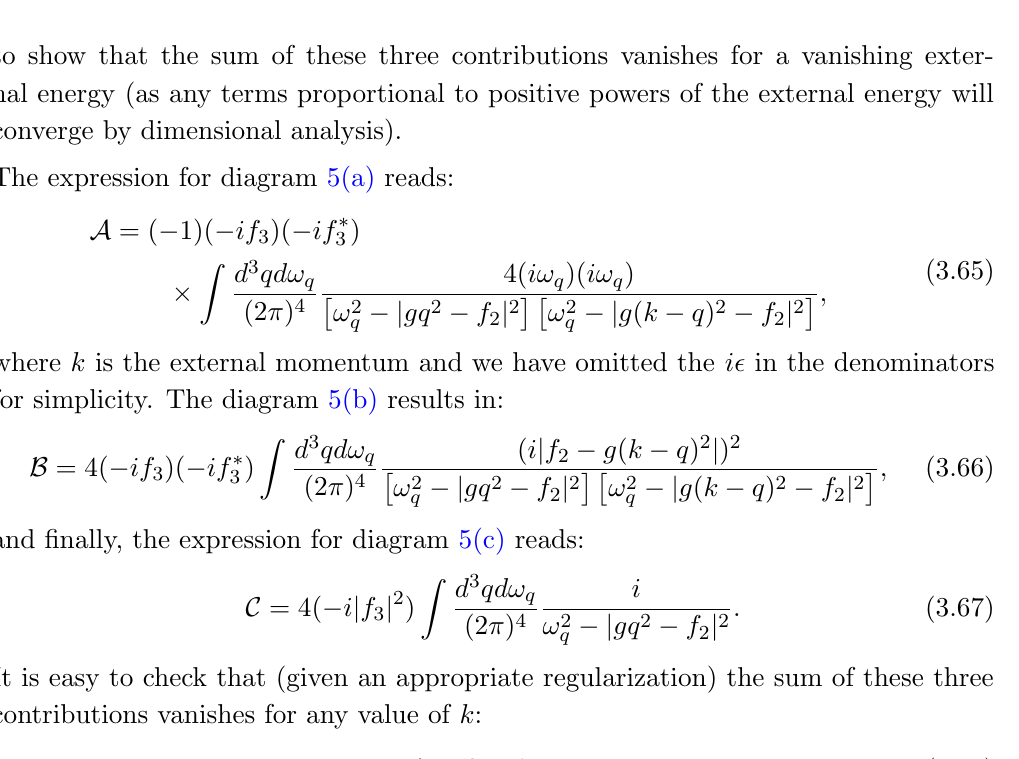
(cid:10) y (cid:11) propagator in the n = 3